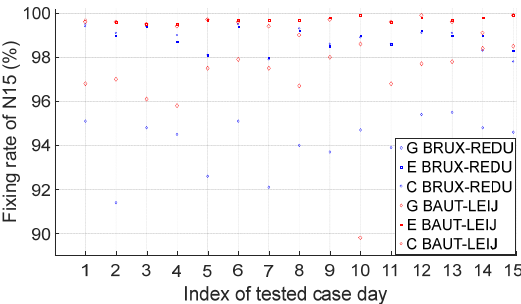
Figure 18. Fixing rate of wide lane N15 for GPS, Galileo and BeiDou.